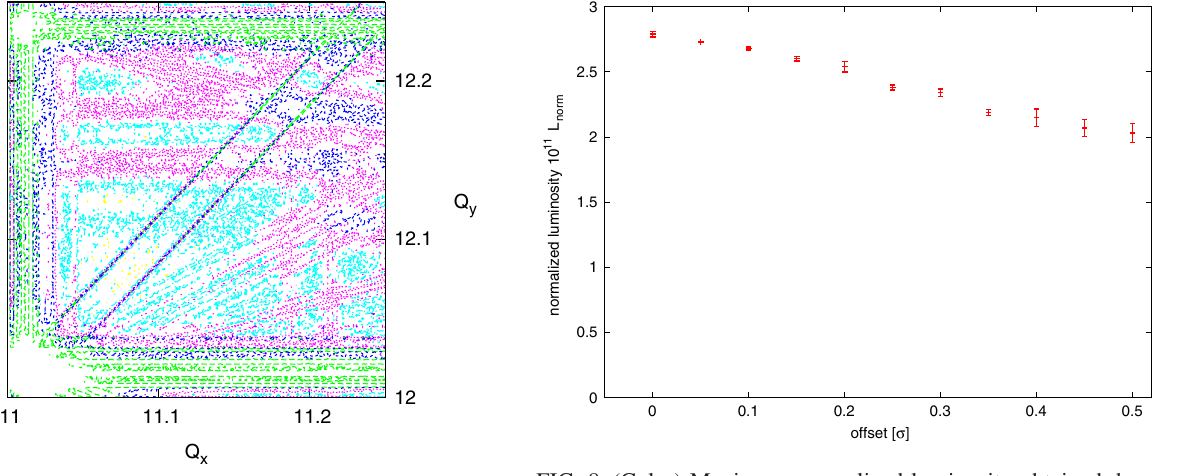
FIG. 6. (Color) Tune scan for a spurious horizontal dispersion of ¼ 1 cm at the electron lens. This tune scan is performed on a D x grid of (cid:1) Q x;y ¼ 0 : 001 to reveal synchrobetatron resonances at a synchrotron tune of Q s ¼ 0 : 015 .